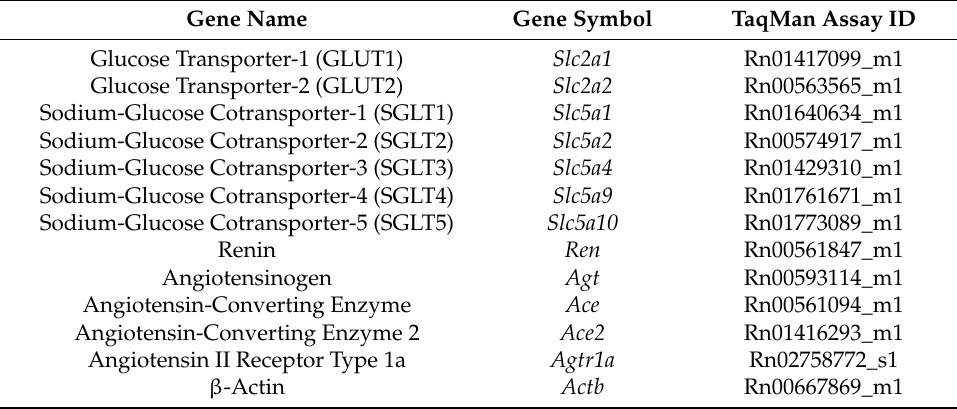
Table 1. TaqMan Assay